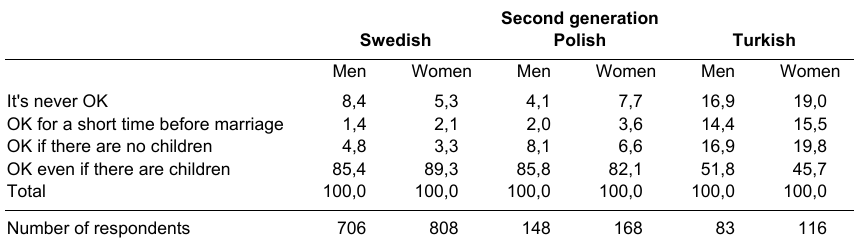
Table 3. Attitudes toward cohabitation among men and women by ancestry